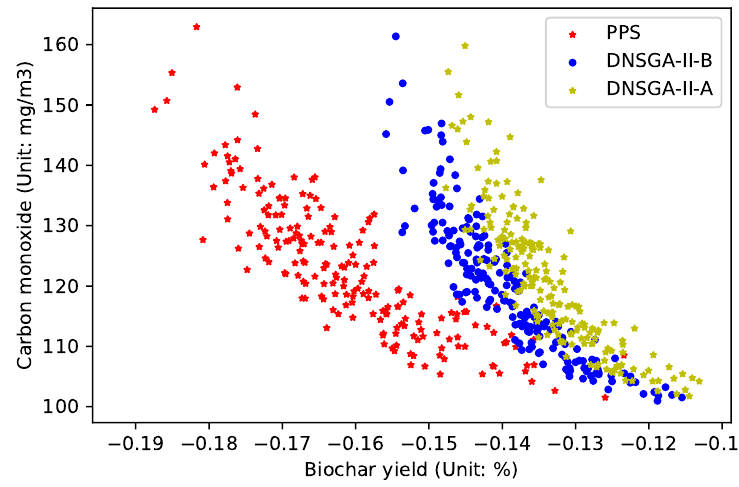
Figure 7. Obtained POF of three algorithms with τ t = 10.